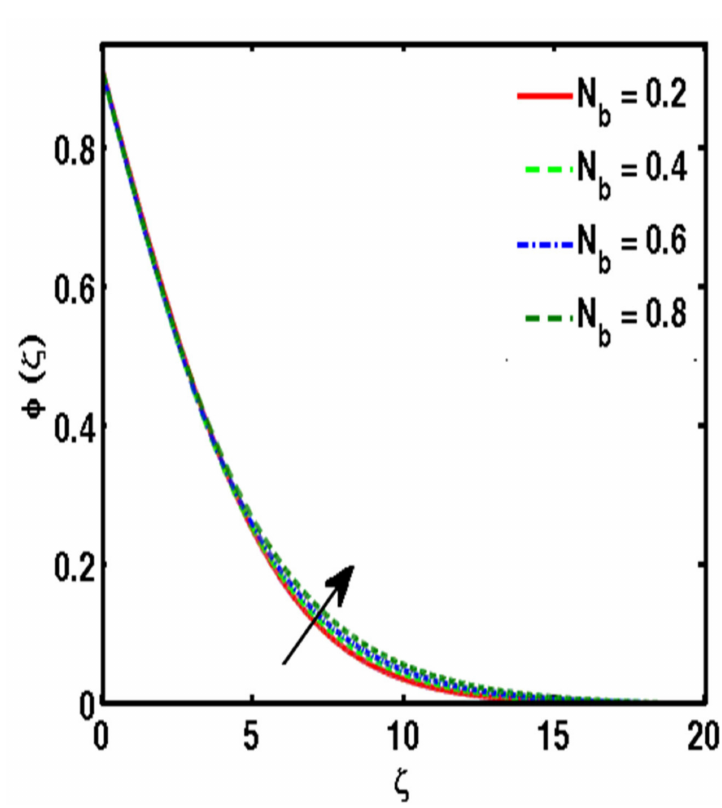
Figure 12. Variation of N b and φ ( ζ )